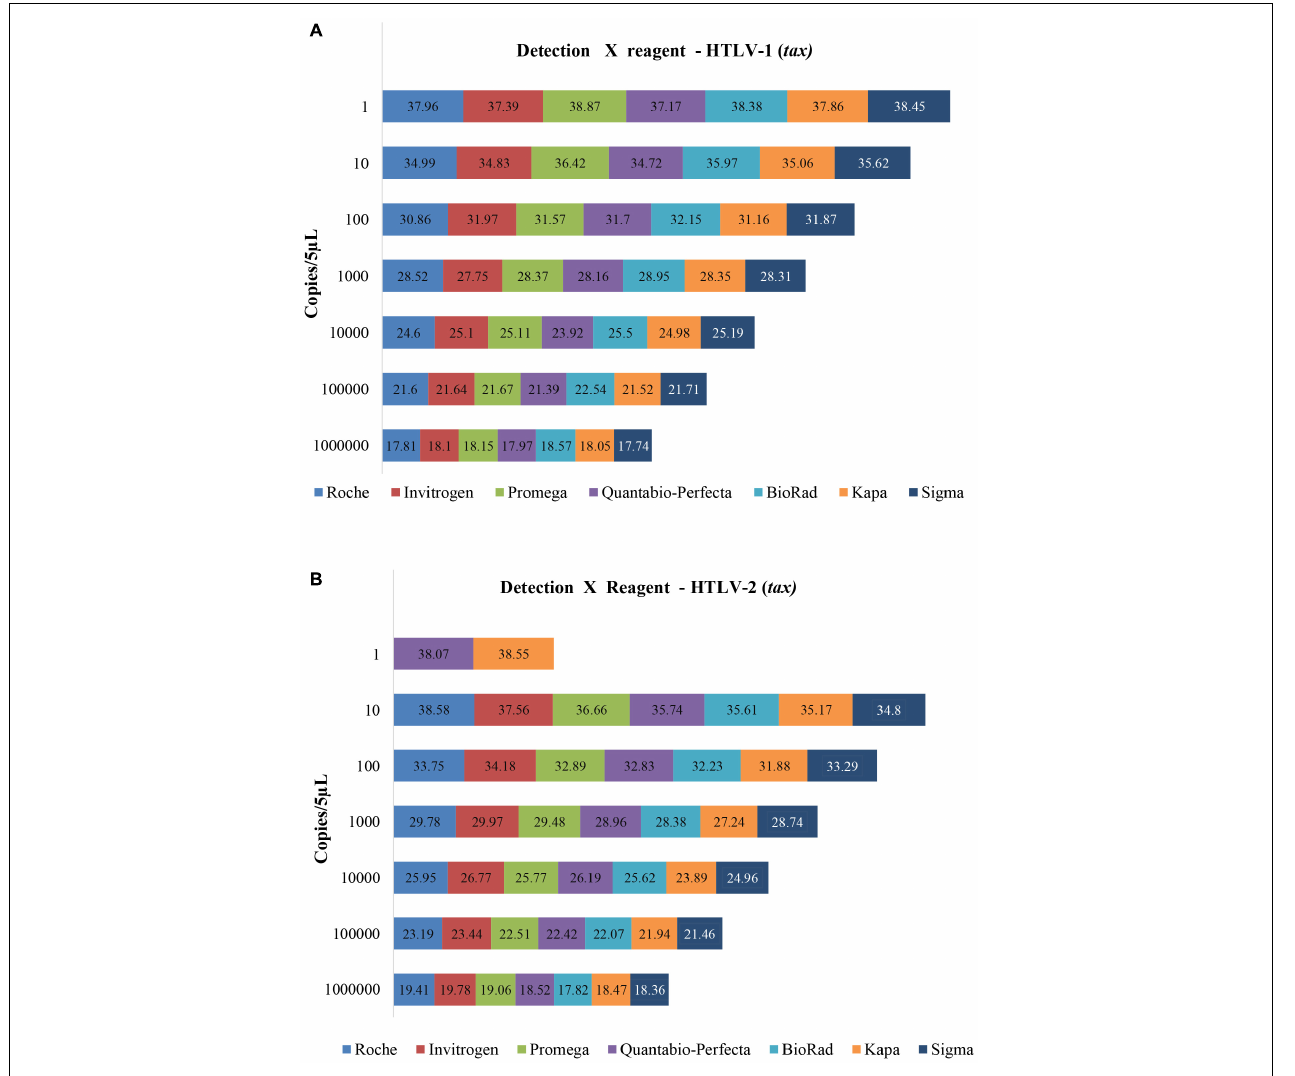
FIGURE 3 | Limit of copy number detection of the mqPCR_HTLV assay ( tax ) for detecting HTLV-1 (A) and HTLV-2 (B) using plasmids and seven different master mix trademarks, and ABI 7.500 equipment. The Cq values are disclosed inside the